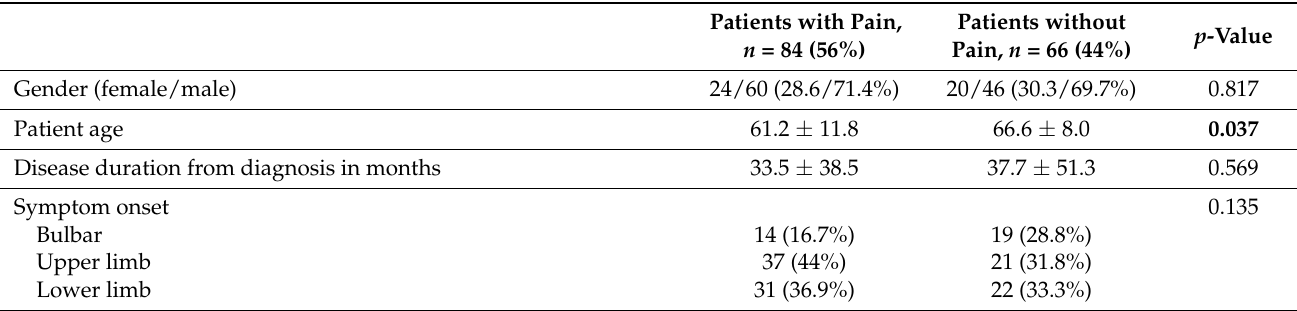
Table 1. Demographic and clinical data of ALS patients with and without pain (mean ± SD or number of patients (%), as